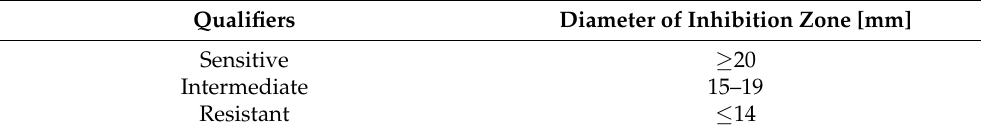
Table 1. Definition of the qualifiers sensitive, intermediate, and resistant according to the diameter of the inhibition zone [52–54]. Qualifiers Diameter of Inhibition Zone [mm] Sensitive ≥ 20 Intermediate 15–19 Resistant ≤